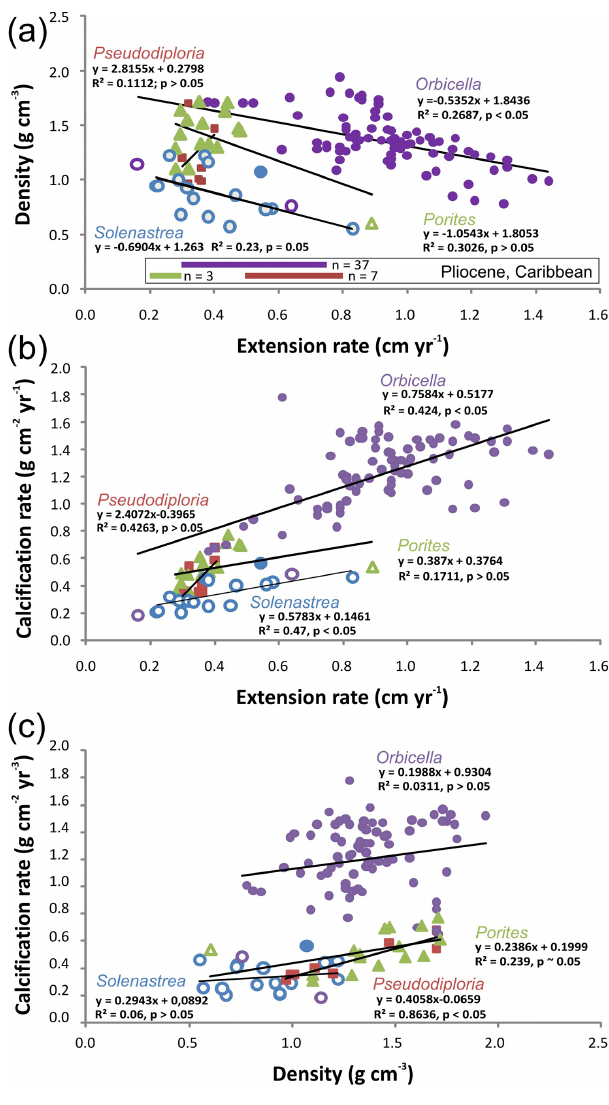
Figure 7. Mean extension rate, bulk skeletal density and mean calci- fication rate of reef corals sorted according to taxon and geological time (Western Atlantic region). Magenta: Orbicella , green: Porites , red: Diploria , blue: Solenastrea . Filled symbols: recent, open sym- bols: fossil. Recent corals compiled from the literature (Carricart- Ganivet et al., 2000; Carricart-Ganivet and Merino, 2001; Dodge and Brass, 1984; Elizalde-Rendon et al., 2010; Highsmith et al., 1983; Hudson et al., 1989; Logan and Tomascik, 1991; Mallela and Perry, 2007) and one unpublished record from Solenastrea (FB-6). Inset in uppermost panel shows range of extension rates of z corals of Pliocene age in the Caribbean region (various taxa) for compar- ison (Johnson and Pérez, 2006). Note clustering of fossil corals at low extension rates, low density and low calcification